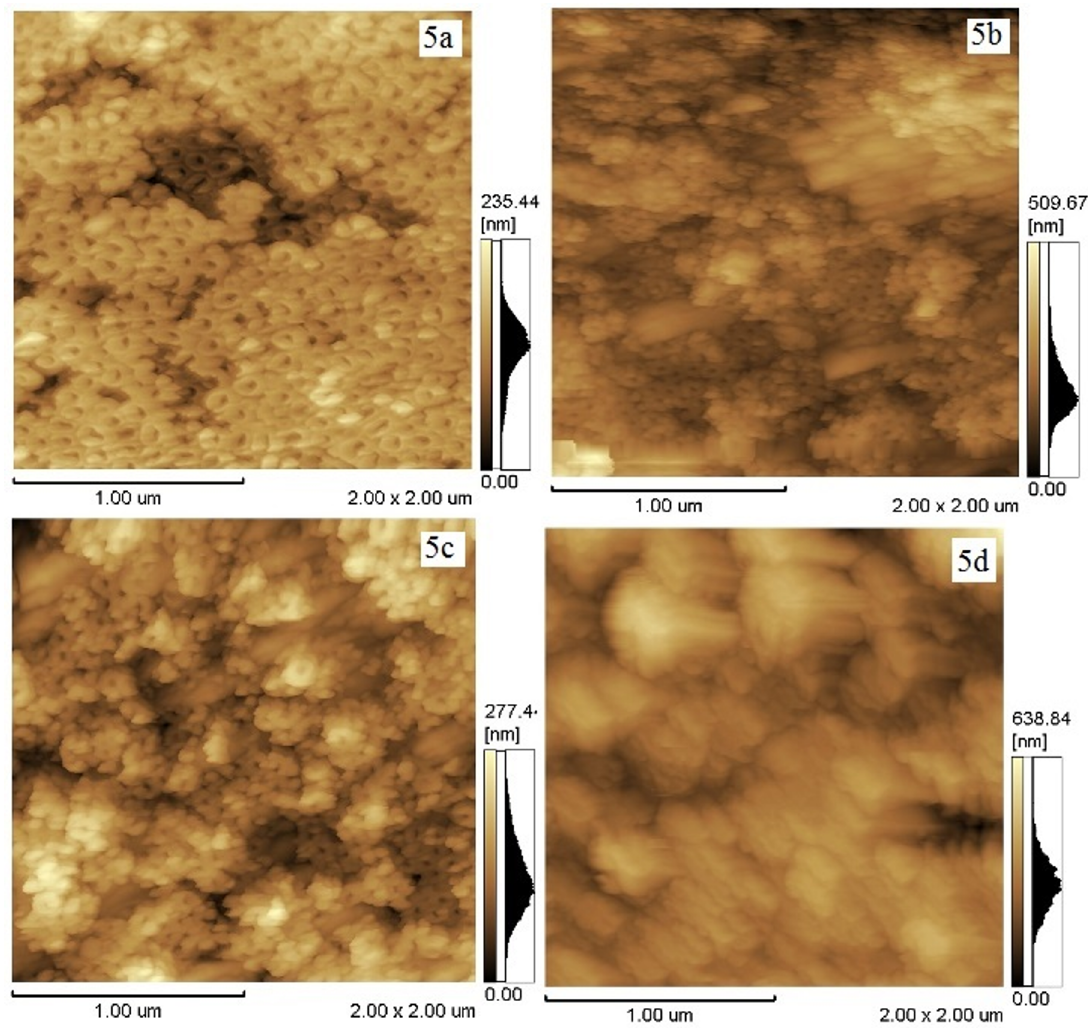
Figure 5. AFM images of the Ti-7.5Mo alloy after anodization at 20V and 30V and calcined at 450 ºC: for 24 hours (5a and 5c) and for 48 hours (5b and 5d)